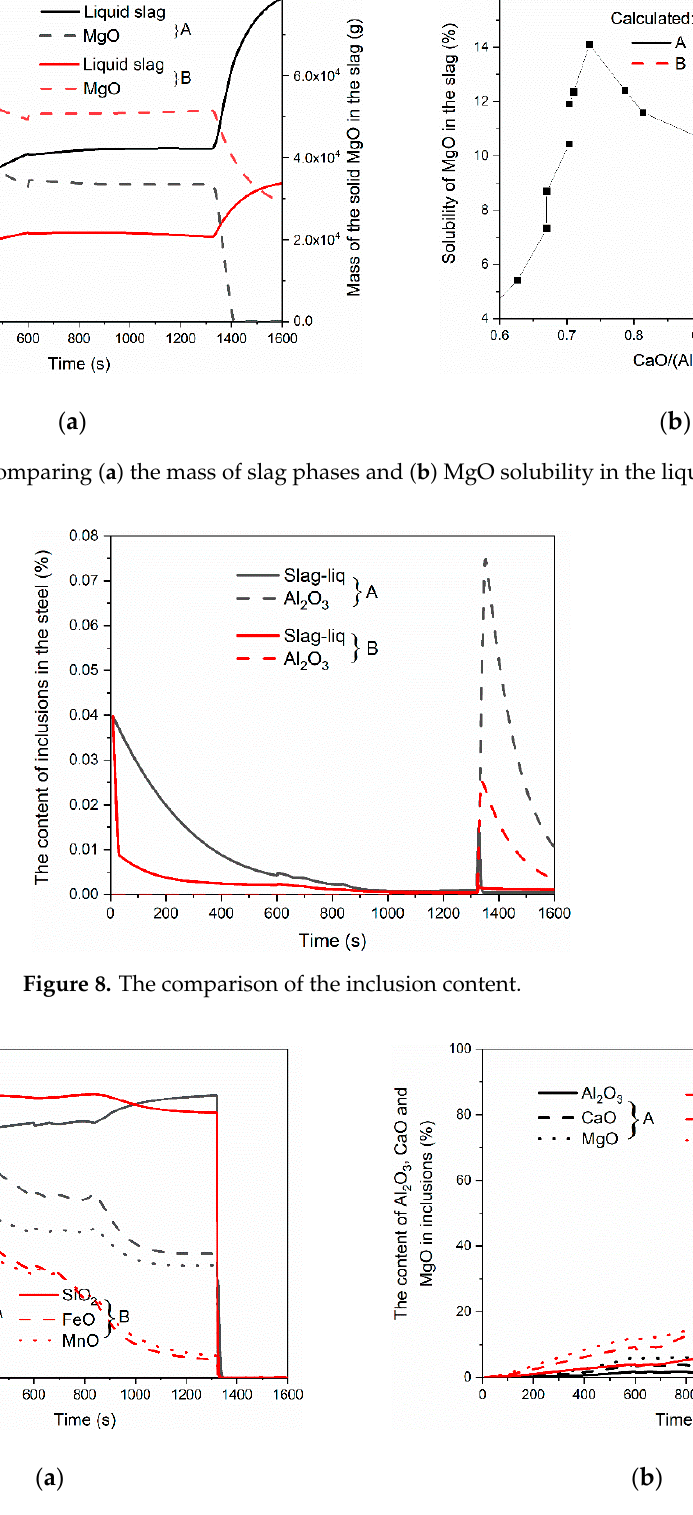
Figure 8. The comparison of the inclusion content. Figure 9. Comparing the overall inclusion compositions in the refining process ( a ) SiO 2 , FeO, and MnO; ( b ) Al 2 O 3 , CaO, and MgO.